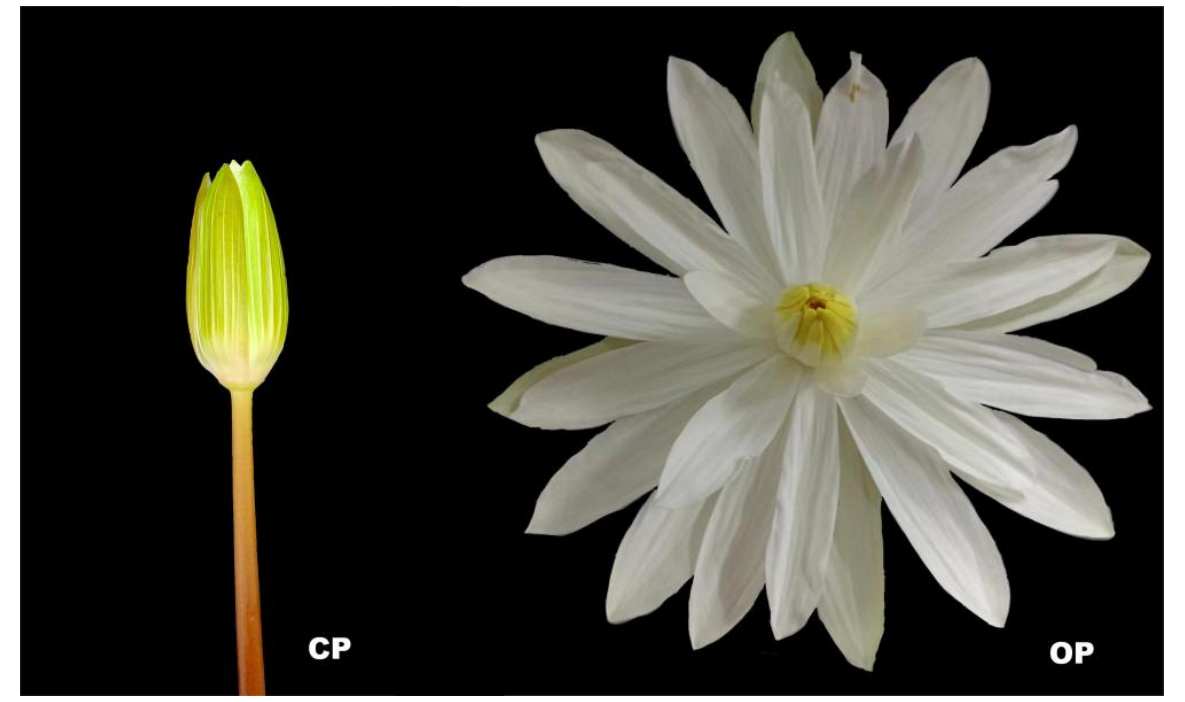
Figure 2. Picture of N. lotus closed (CP) and open (OP).